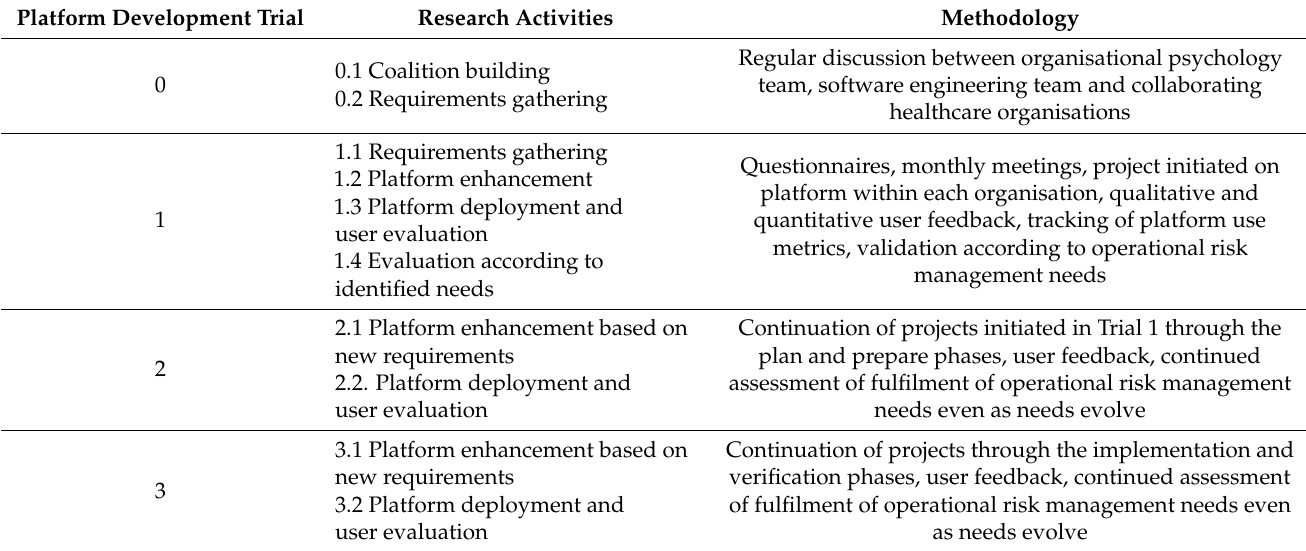
Table 1. ARK-Virus Project phases and research activities